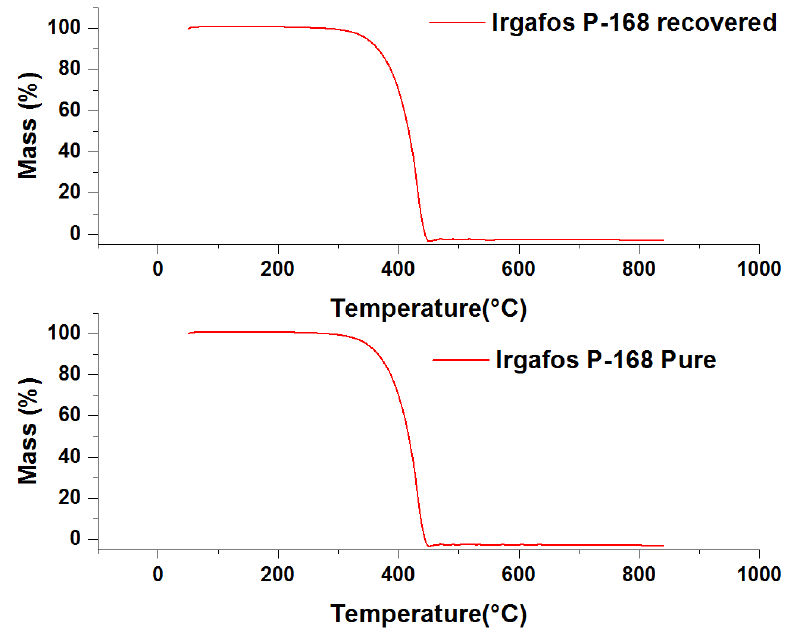
Figure 10. Pure Irgafos P-168 TGA and recovered Irgafos P-168 TGA.